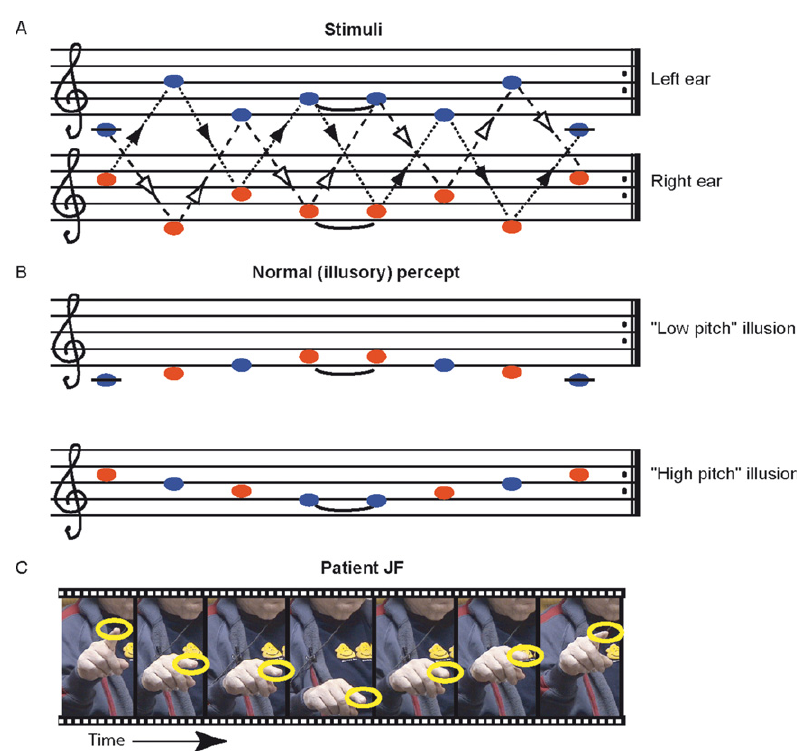
Figure 2. The scale illusion. (A) Repeating sequences of tones are presented to the right and left ears simultaneously. Dashed lines with open arrowheads connect notes which belong to an ascending scale, whereas dotted lines with closed arrowheads connect notes which belong to the descending form of the same scale. The two scales alternate between the two ears. (B) Normal listeners group notes from the left (blue) and right (red) ear to perceive one or two illusory ‘melodies’, each consisting of the higher or lower half of the scale; they typically ascribe each melody to a different ear. (C) Movie frames from Movie S1 (supplementary material), showing the patient indicating with his fi nger the perceived pitch of each tone as he listens to the sequences shown in (A) . The frames were taken at points where the fi nger paused. The sequence resembles the illusory percept shown in (B)